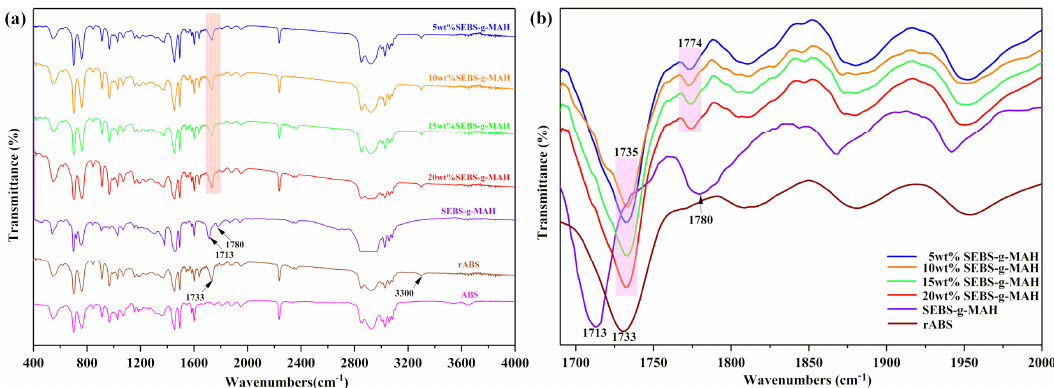
Figure 8. FT-IR spectra of neat ABS, neat rABS, neat SEBS-g-MAH and rABS / SEBS-g-MAH blends: ( a ) wave numbers from 4000 to 400 cm − 1 , and ( b ) wave numbers from 2000 to 1680 cm − 1 .